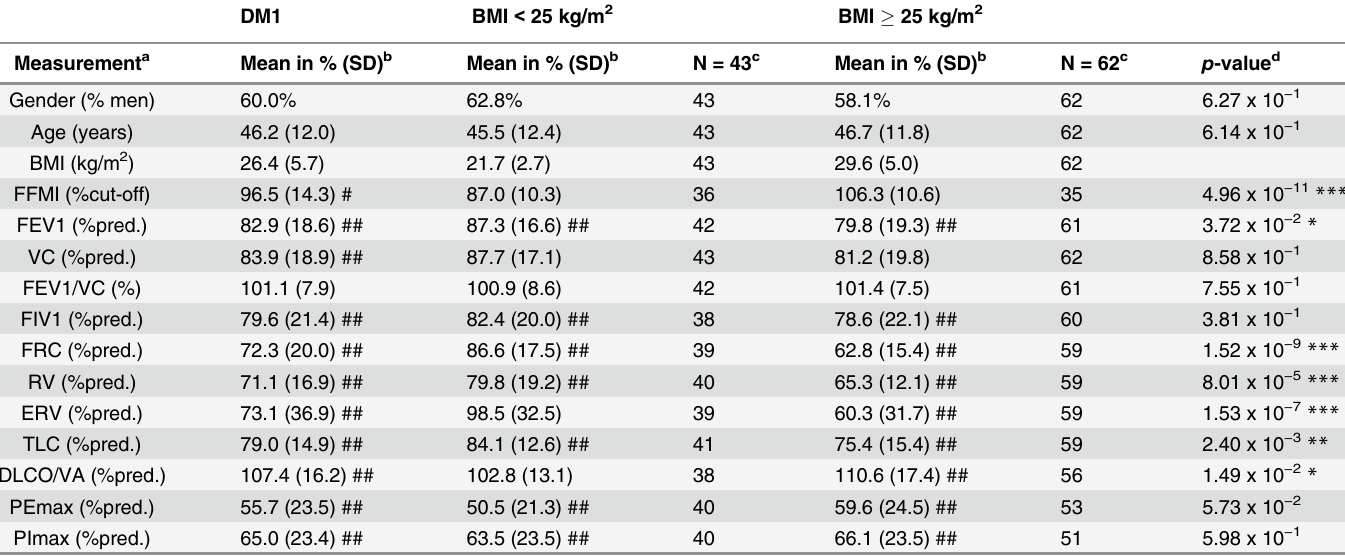
Table 1. Respiratory function in 105 monotonic dystrophy type 1 (DM1) patients, normal weight (body mass index [BMI] < 25 kg/m 2 ) and over- weight (BMI (cid:1) 25 kg/m 2 ).